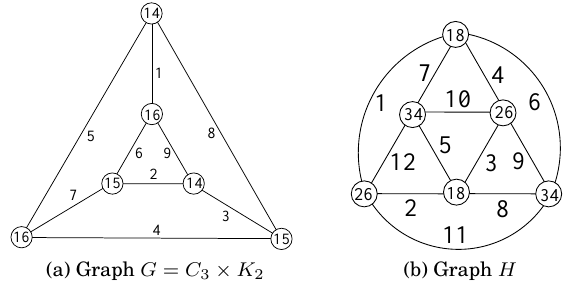
Figure 2: Local antimagic 3 -colorings of graphs G and H